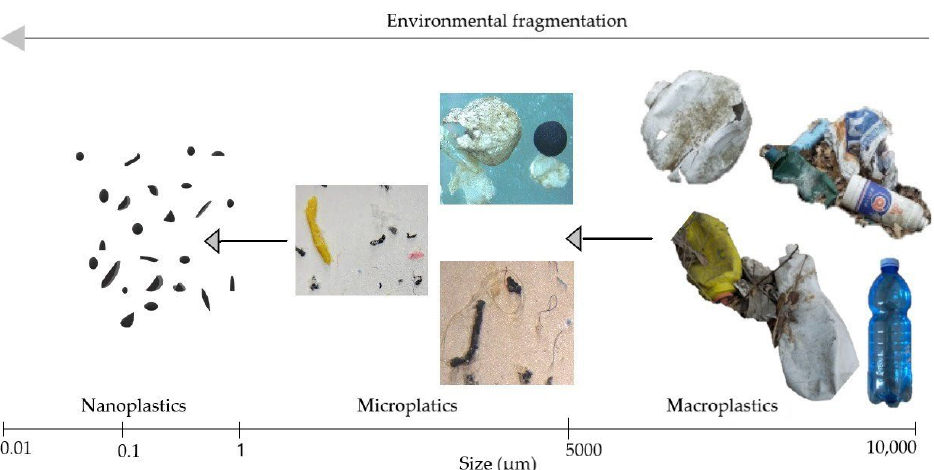
Figure 2. Graphical representation of plastic debris of macro, micro, and nano size (please note that the images representing plastic particles are not in scale).